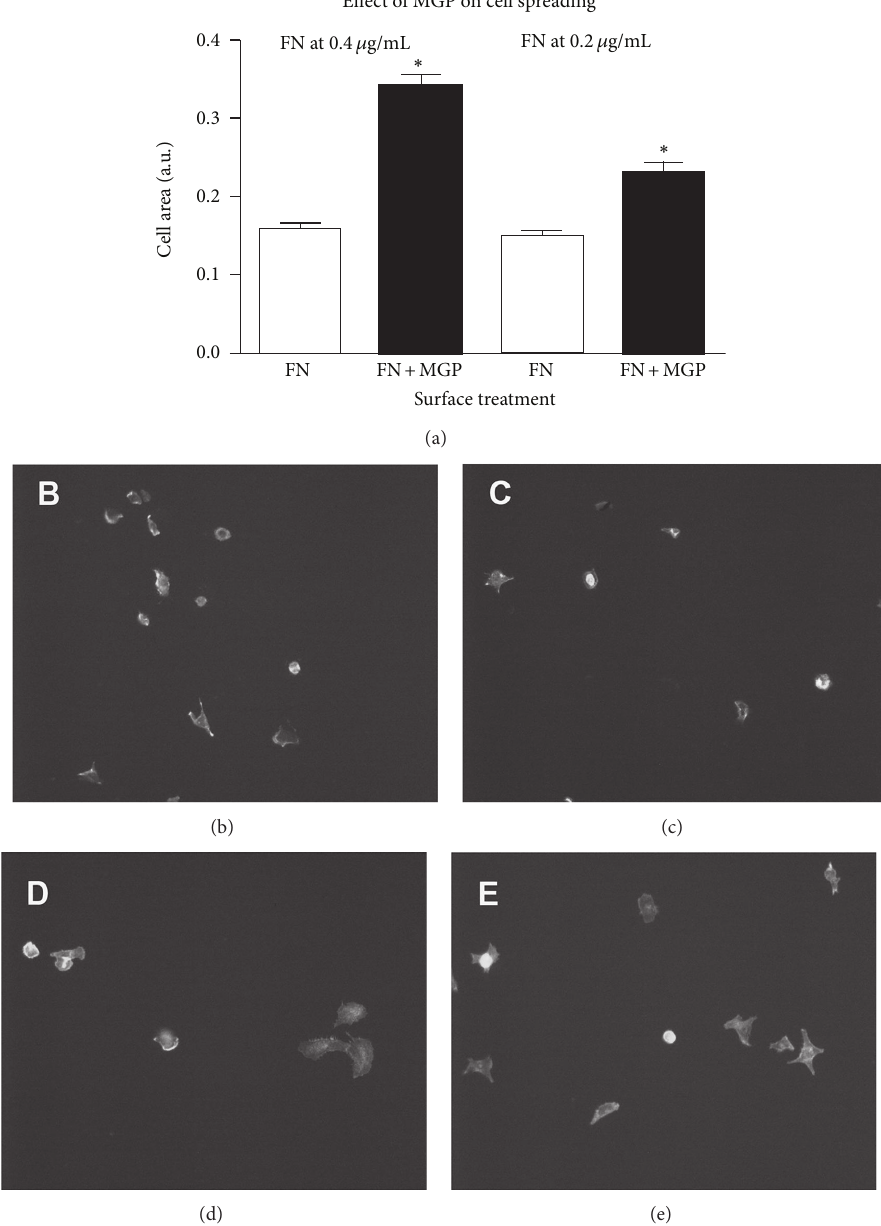
Figure 5: MGP augments cell spreading on fibronectin. In Panel (a) the graph shows the calculated cell area/cell for fibronectin coated surfaces compared to fibronectin plus MGP coated surfaces. FN is fibronectin alone open bars at 0.4 𝜇 g/mL (left) or 0.2 𝜇 g/mL (right); FN + MGP dark bars is the indicated concentration of fibronectin plus MGP at 3 𝜇 g/mL. The asterisk indicates that the combination of FN + MGP was significantly different from FN at each concentration of FN ( 𝑃 ≤ .0001 , error bars are SEM). The average cell area from a minimum of 100cells in 14 to 16 random microscopic fields is shown. Cells were allowed to attach for 2 hours in serum-free medium then fixed, stained, and imaged and the cell area quantified. Area per cell was determined by NIH Image software as described in experimental procedures. Panels (b) and (c) are images of cells attached to fibronectin alone (0.4 𝜇 g/mL), and Panels (d) and (e) are images of cells attached to fibronectin plus MGP (0.4 𝜇 g/mL and 3 𝜇 g/mL,